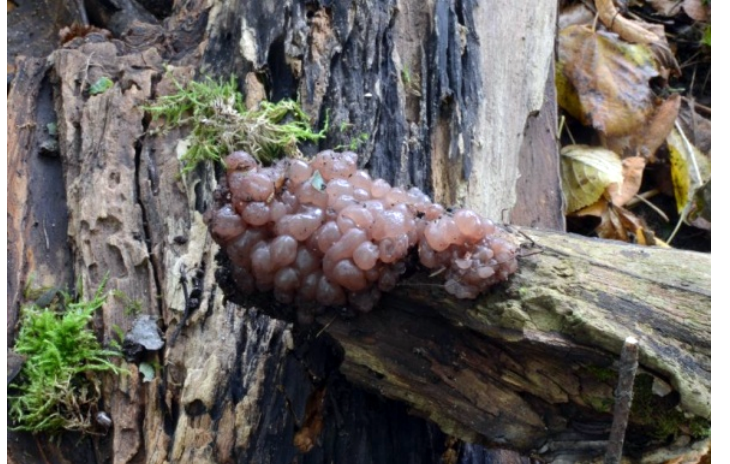
Figure 1 Ascotremella faginea . Photo by B.